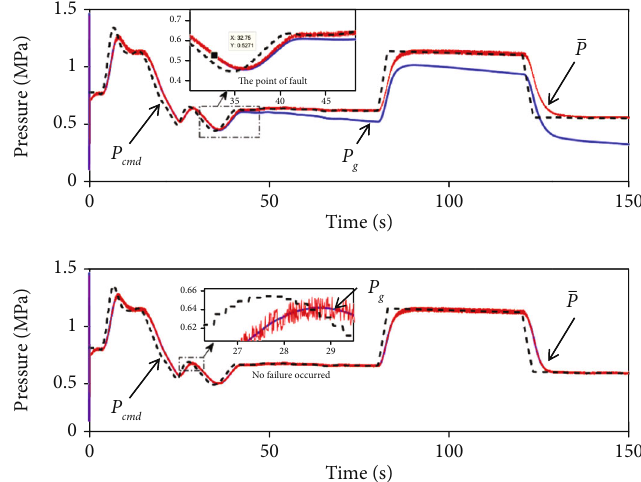
Figure 2: In fl uence of closed-loop control on fault